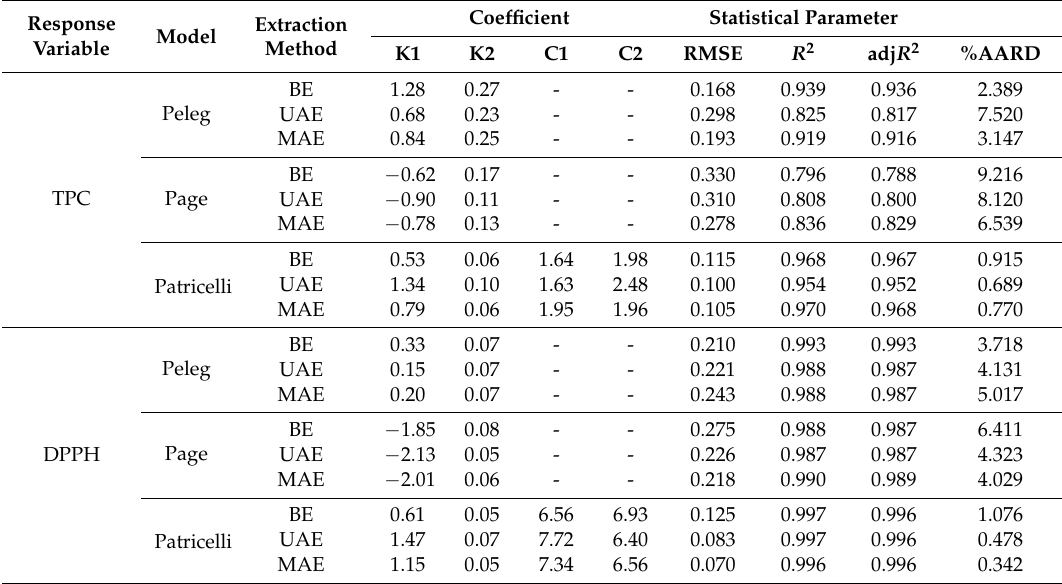
Table 6. Coefficients and statistical parameters of extraction modelling for all models ( p <